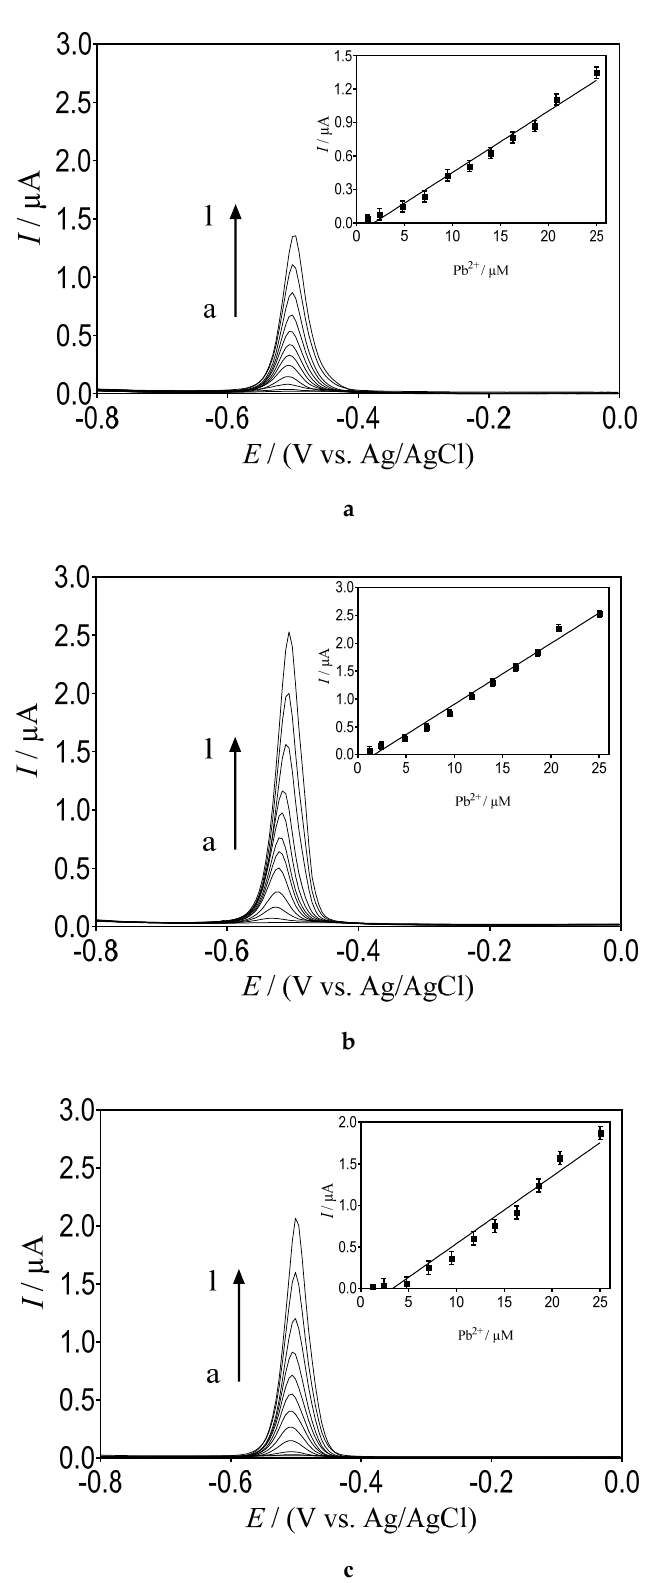
Figure 3. DPASV curves recorded for different concentrations of Pb(II) with ( a ) GrRAC-10%, ( b ) GrRAC-70%, and ( c ) GrRAC-90%. Lead concentrations: (a) 0, (b) 1.2, (c) 2.4, (d) 4.8, (e) 7.1, (f) 9.5, (g) 11.8, (h) 14.0, (i) 16.3, (j) 18.6, (k) 20.8, (l) 25 µ M. Inserts: plots of the electrochemical response, in terms of current, as a function of the lead